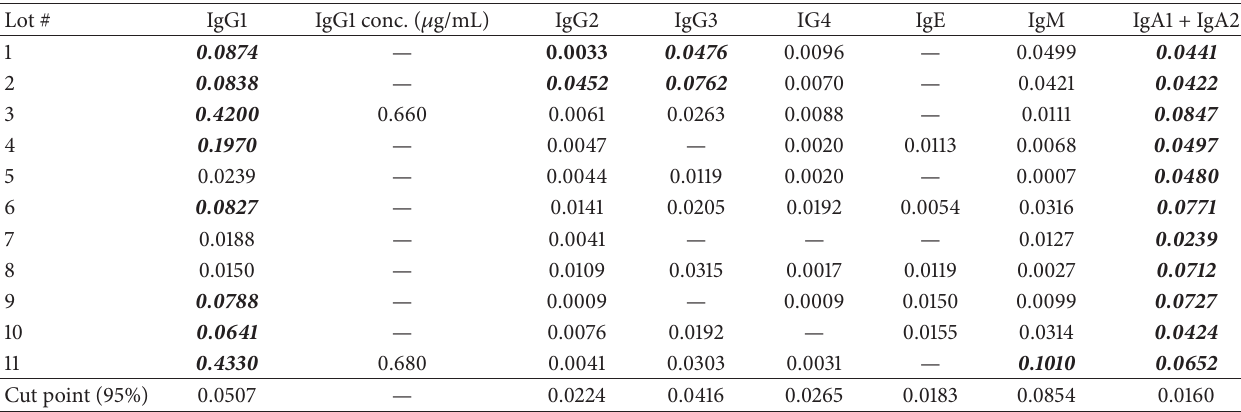
Table 3: LC/MS peak area ratio responses and calculated ADA isotope/subclass levels in PEA positive human plasma with drug as ADA capture reagent (numbers in bold italic are above respective